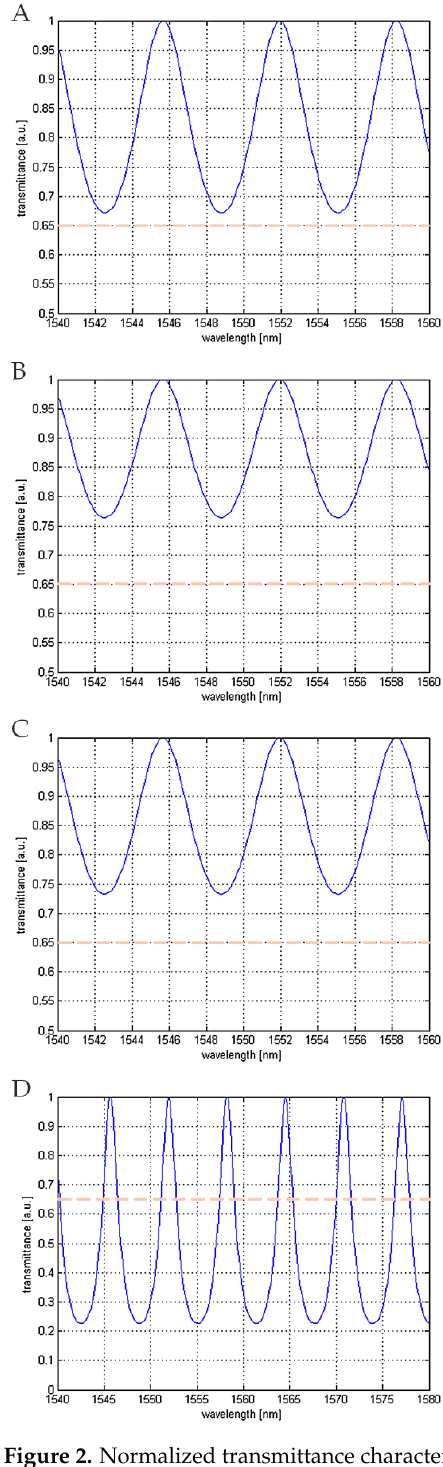
Figure 2. Normalized transmittance characteristics. ( A ) Silver mirror, ( B ) boron-doped diamond film, ( C ) nitrogen-doped diamond film and ( D ) nanocrystalline diamond sheet with silver mirror. Orange lines are meant to guide an